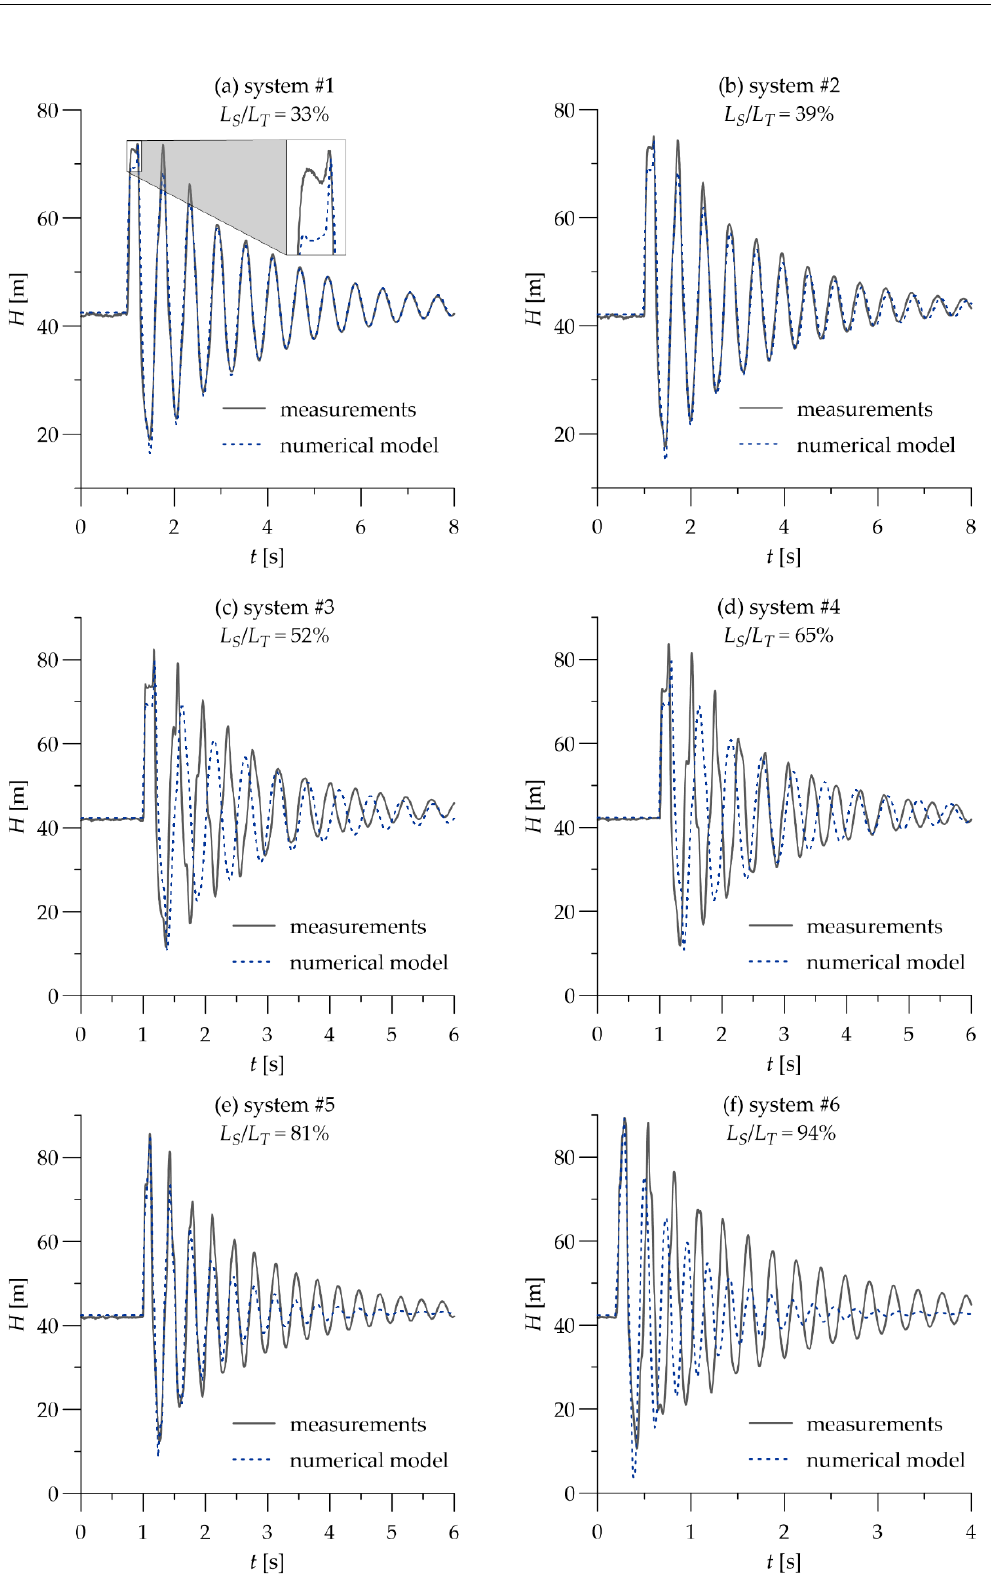
Figure 10. Comparison between calculated and measured pressure oscillations: ( a ) System #1; ( b ) System #2 ; ( c ) System #3 ; ( d ) System #4; ( e ) System #5; and ( f ) System #6.